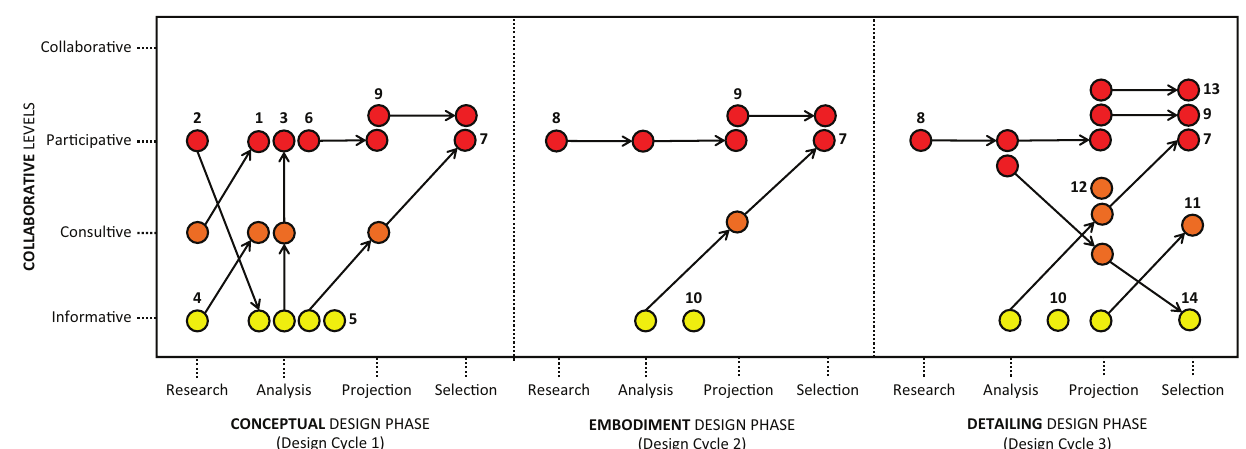
Figure 4. Mapping the use of VCMs in the co‐design process framework. Collaborative levels on the Y‐axis and the design cycle and phases on the